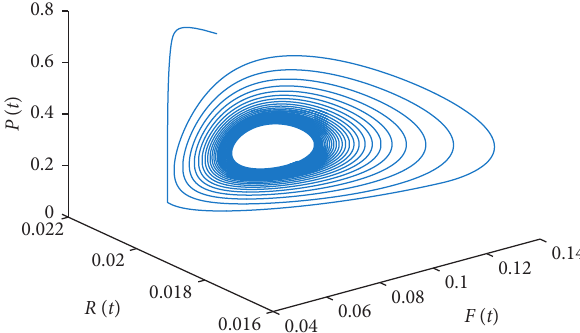
Figure 14: Portrait diagram of land model (30) with ϕ � 0 . 90, � 728 . 403. τ � 740 > τ 0